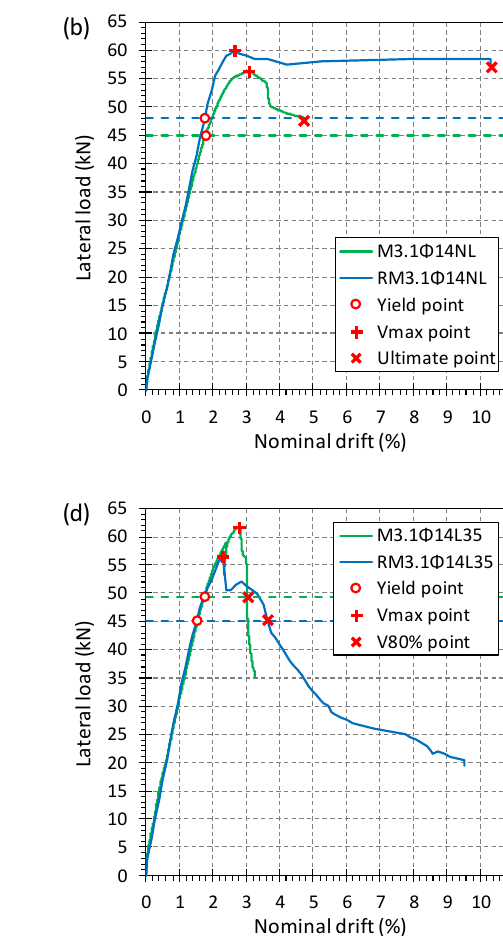
Figure 11. Failure modes of specimens: ( a.1 ) M1.6 Φ 10 Ν L vs. ( a.2 ) RM1.6 Φ 10 Ν L; ( b.1 ) M3.1 Φ 14 Ν L vs. ( b.2 ) RM3.1 Φ 14 Ν L;